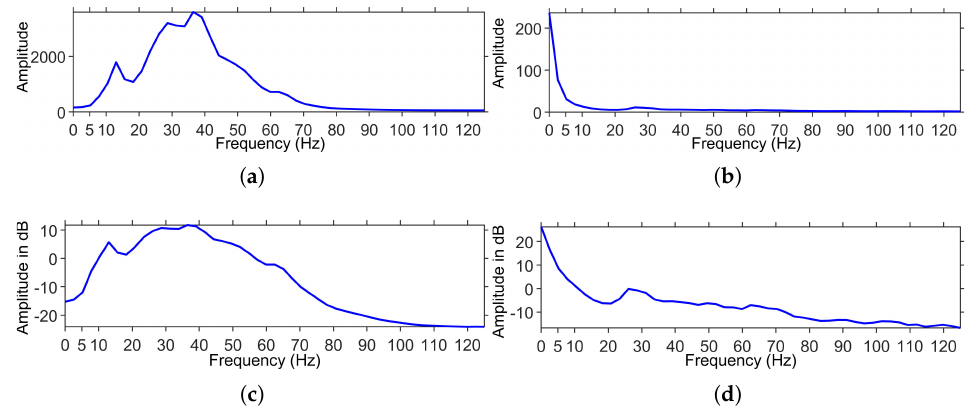
Figure 10. ( a ) Fourier spectral amplitude of the raw data shown in Figure 9a. ( b ) Fourier spectral amplitude of the predicted LF data shown in Figure 9d. ( c ) Fourier power spectra in dB of the raw data shown in Figure 9a. ( d ) Fourier power spectra in dB of the predicted LF data shown in Figure 9d.